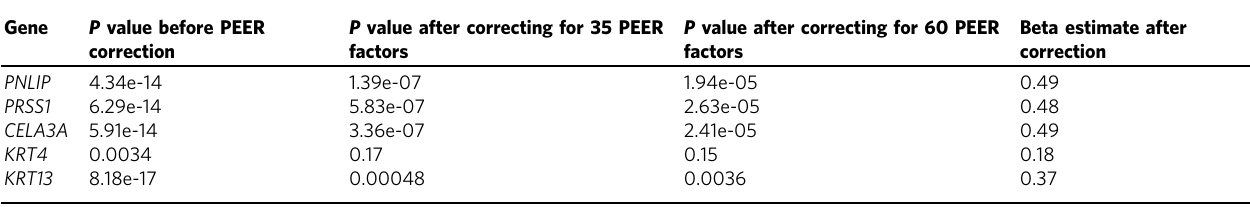
P values are shown before and after PEER